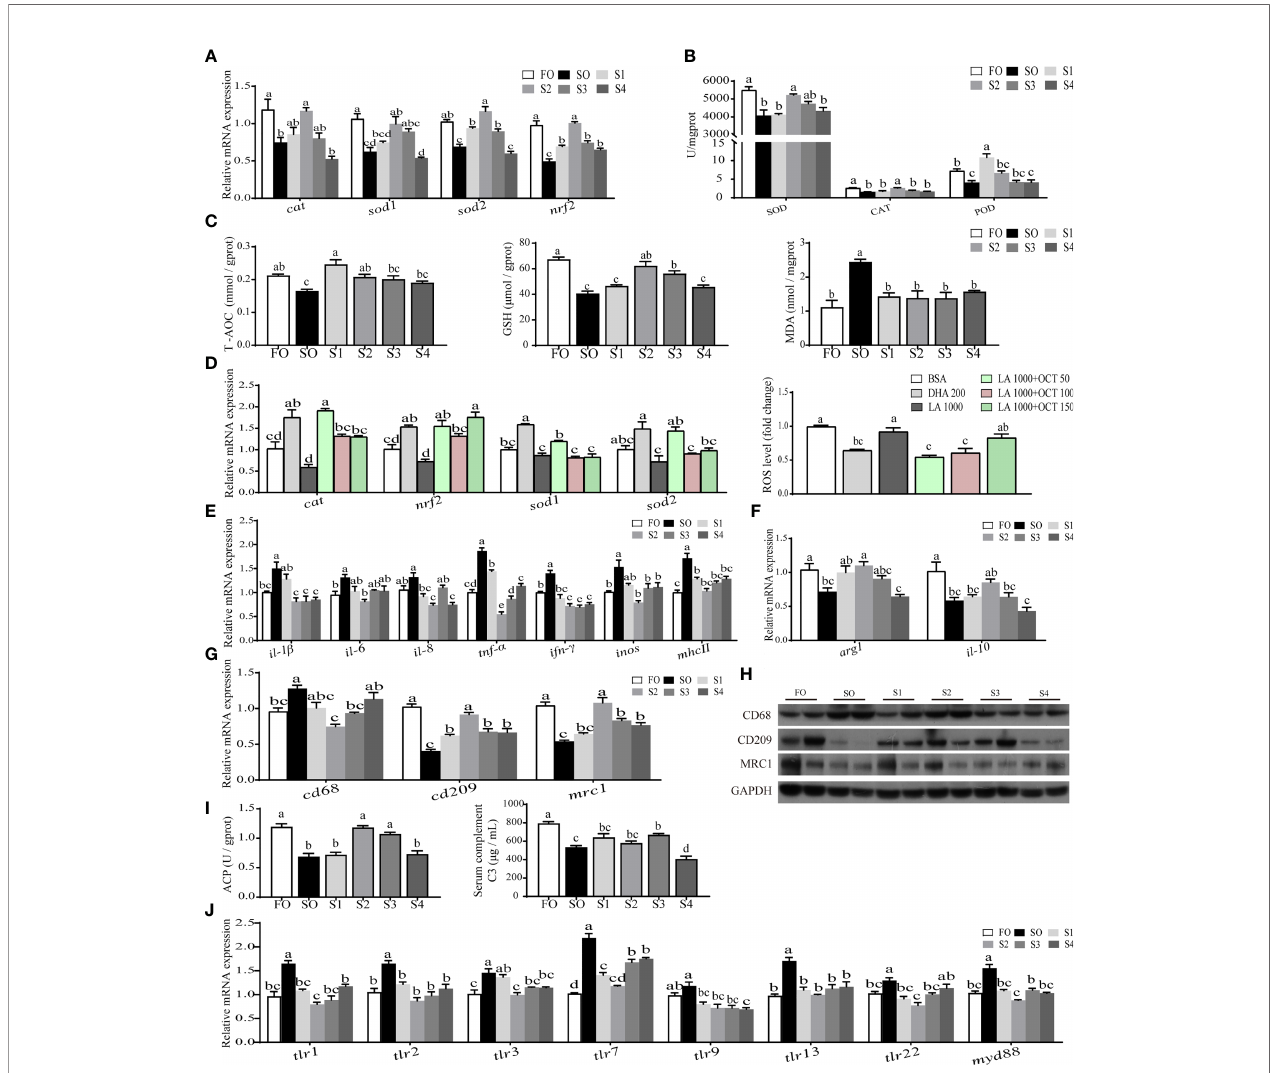
FIGURE 2 | Octanoate supplementation reduced dietary SO-induced intestinal oxidative stress and in fl ammatory response. The relative mRNA level of key antioxidation-related genes ( cat , nrf2 , sod1 , and sod2 ) in the intestinal tissue were measured (A) . The activities of SOD, CAT, and POD in the intestinal tissue were measured (B) . The level of T-AOC, MDA, and GSH in the intestinal tissue were tested (C) . The relative mRNA expression of key antioxidation-related genes ( cat , nrf2 , sod1 , and sod2 ) and the fold change of ROS in treated intestinal cells were measured (D) . The relative mRNA expression of proin fl ammatory cytokines ( il-1 b , il-6 , il-8 , tnf- a , ifn- g , inos , and mhc Ⅱ ) (E) and anti-in fl ammatory cytokines ( arg1 and il-10 ) (F) in the intestinal tissue were measured. The relative mRNA (G) and protein (n = 2) (H) level of CD68, CD209, and MRC1 in the intestinal tissue were measured. The activity of ACP in the intestinal tissue and the level of serum C3 were measured (I) . The relative mRNA expression of tlr1 , tlr2 , tlr3 , tlr7 , tlr9 , tlr13 , tlr22 , and myd8 8 in the intestinal tissue were measured (J) . Data were presented as means ± S.E.M. Means in each bar sharing the same superscript letter or absence of superscripts were not signi fi cantly different determined by Tukey ’ s test ( P ≥ 0.05). S.E.M.: standard error of means (n =